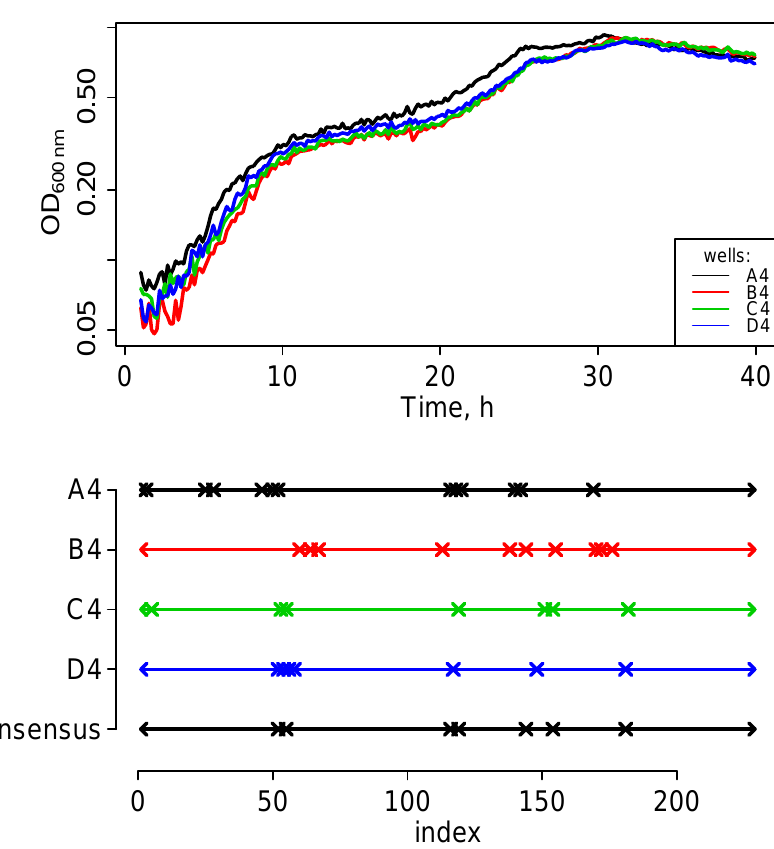
Figure 6. Four Escherichia coli cultures were grown at identical conditions (four replicates in a larger experiment) in M9 medium with 0.2% glucose at 37 ◦ C in a BMG Clariostar platereader and the optical density at 600 nm, ln ( OD 600 nm was measured every 10 minutes. The growth curves of each of the four replicates were segmented into intervals with constant slope by the dpseg algorithm with the default jump penalty parameter P = 0 [41].